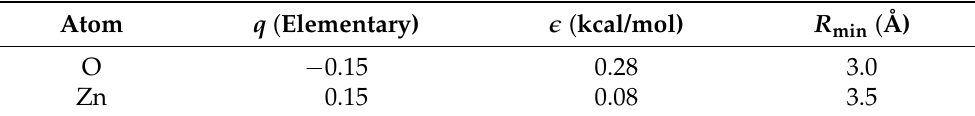
Table 2. Optimized ZnO model interaction parameters.